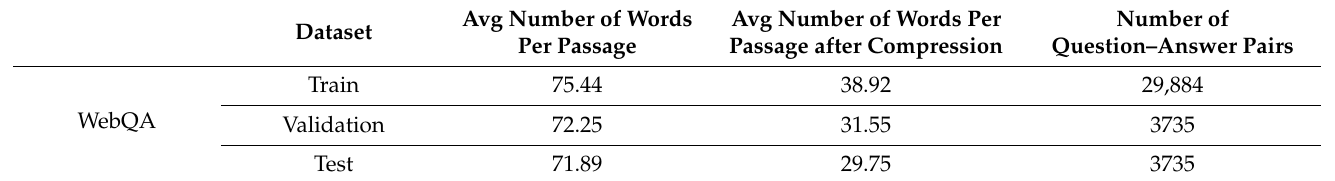
Table 3. Dataset